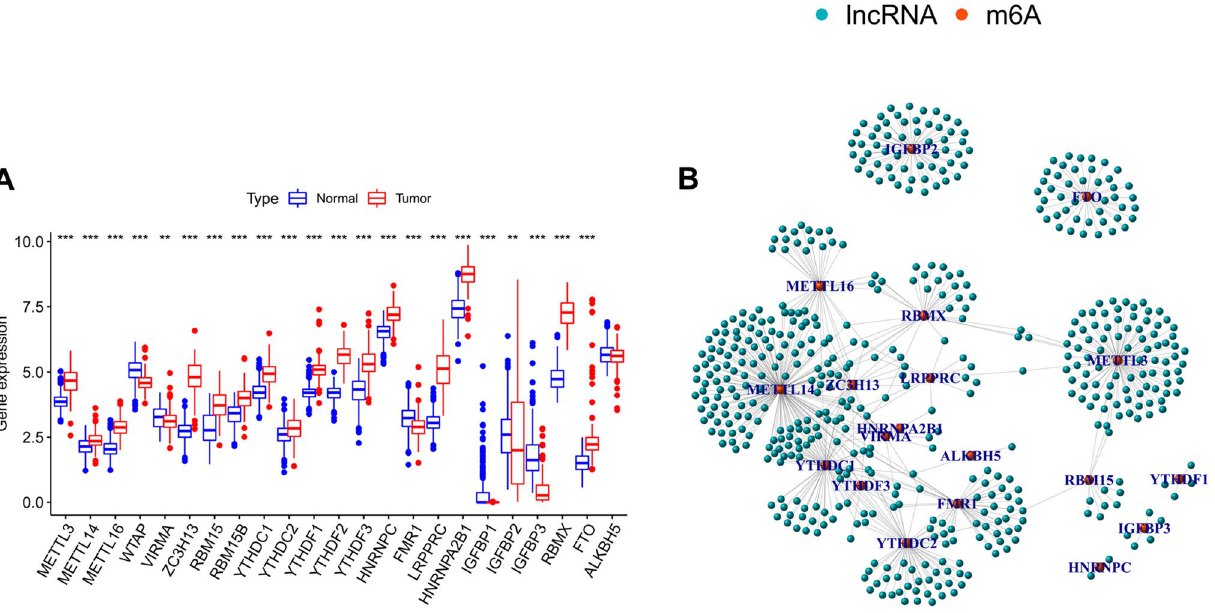
Figure 1. Identifying m 6 A regulatory genes and related lncRNAs. ( A ) The levels of expression of m 6 A regulatory genes in tumor and normal samples. The Wilcoxon test was used to determine the statistical significance of the difference, *P < 0.05, **P < 0.01, ***P < 0.001. ( B ) Correlation network of m 6 A regulatory genes and related lncRNAs in AML, blue nodes are m 6 A-regulated lncRNAs whose expression correlate with the m 6 A regulators, and that lines indicate